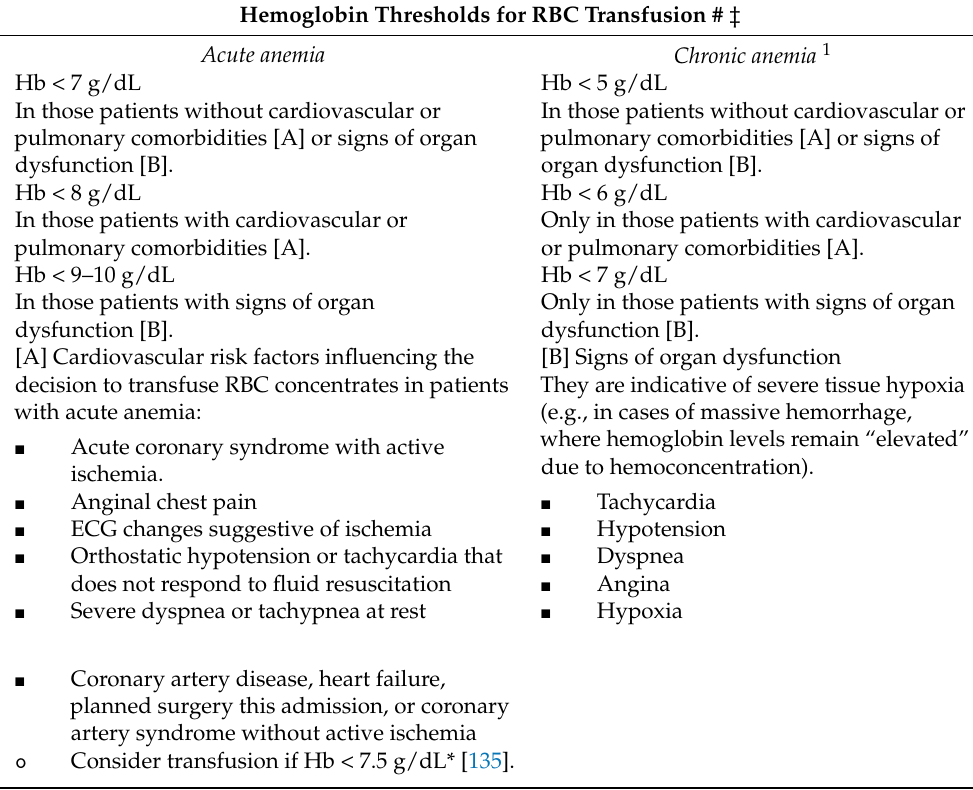
Table 2. Indications and hemoglobin thresholds for RBC transfusion in the adult with acute or chronic